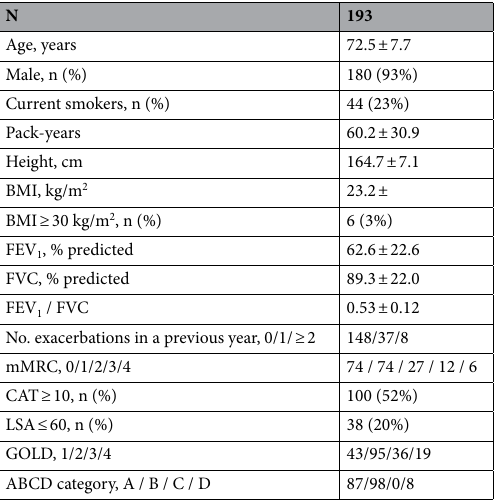
Table 1. Patients’ Characteristics. Data are expressed as mean ± SD and n (%). BMI = body mass index, Exacerbation in a past year = a history of at least one exacerbation in the previous one year, mMRC = modified